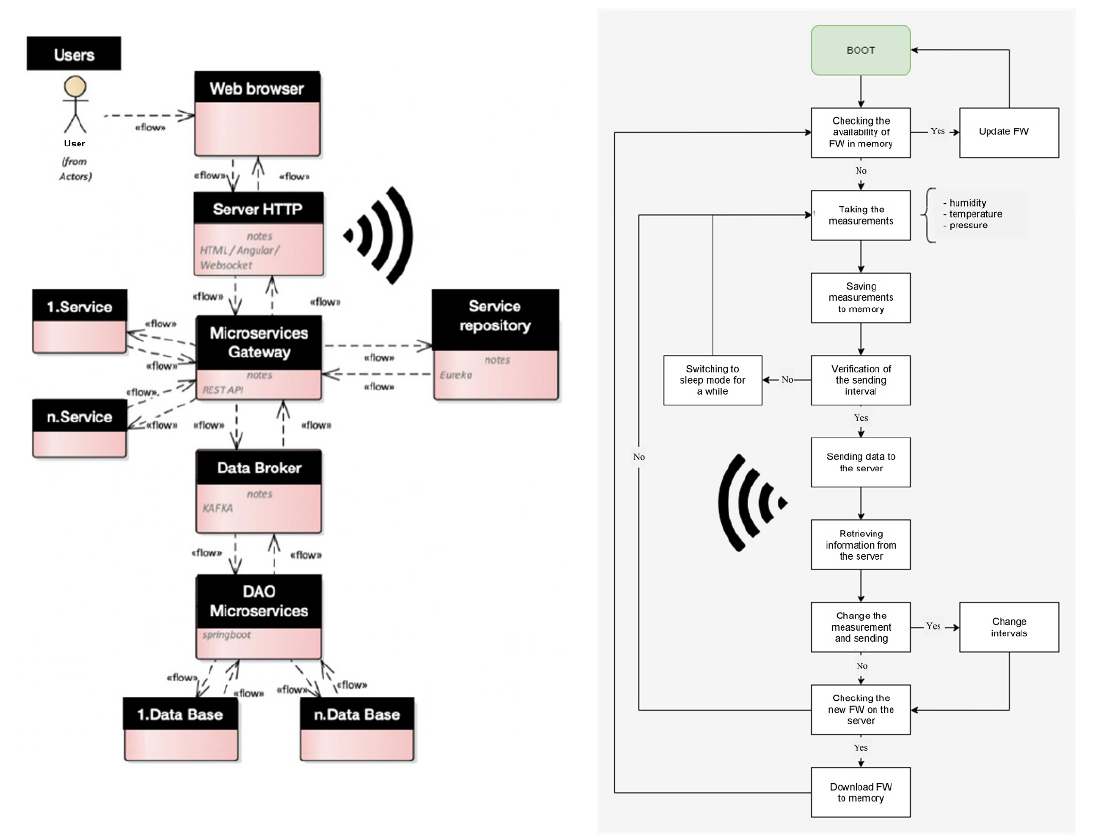
Figure 6. Algorithm for the operation of the central unit of the measurement module.